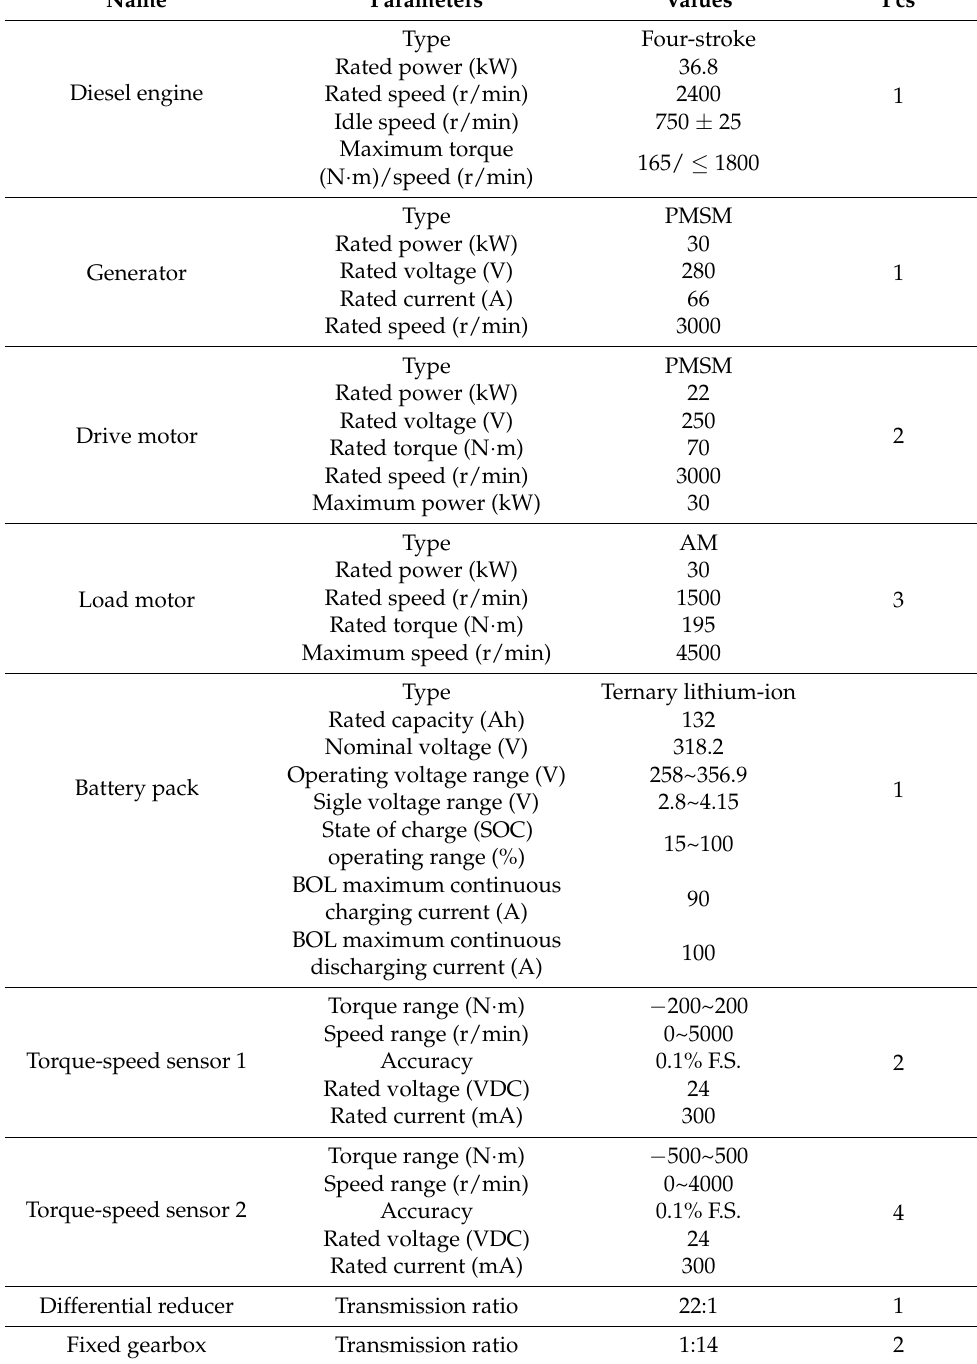
Table 1. Main technical parameters of the